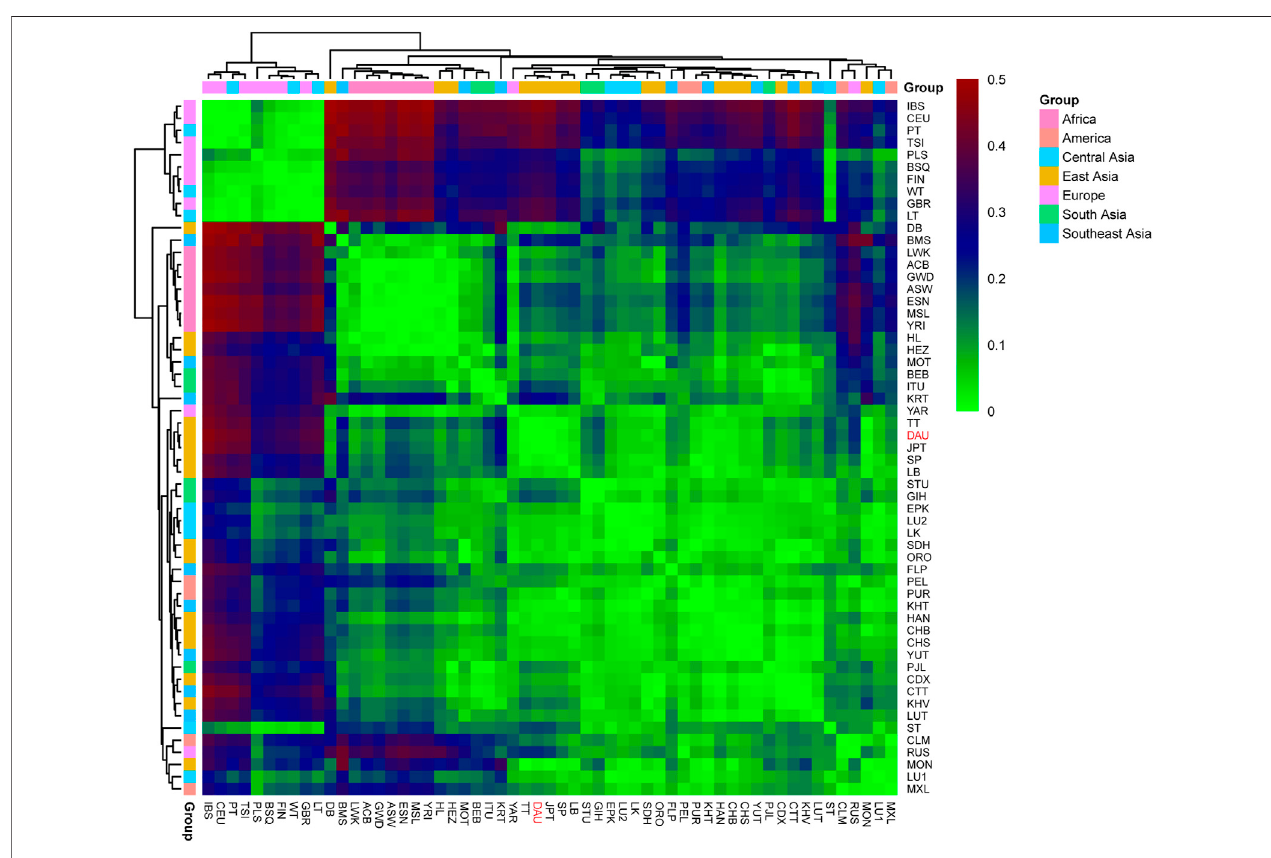
FIGURE 7 | Heatmap for genetic distance among the Daur ethnic group (DAU) and 56 worldwide populations. Visualizing the F ST values with different colors. The color red represents the high F ST values, and the green represents the low F ST values. DAU is highlighted in red.